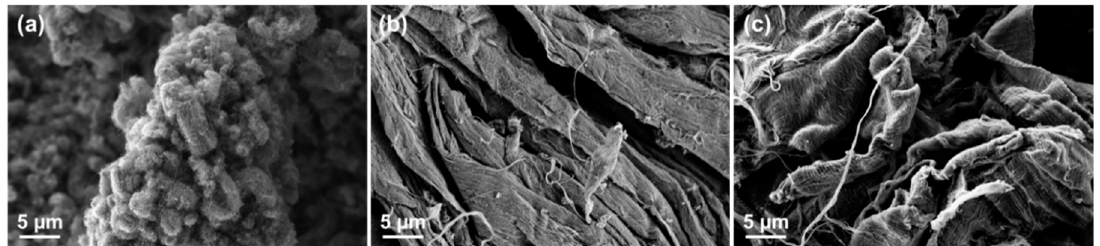
Figure 1. SEM micrograph of fillers: ( a ) multiwalled carbon nanotubes (MWCNT) NC7000, ( b ) singlewalled carbon nanotubes (SWCNT) Tuball, and ( c ) branched multiwalled carbon nanotubes (b-